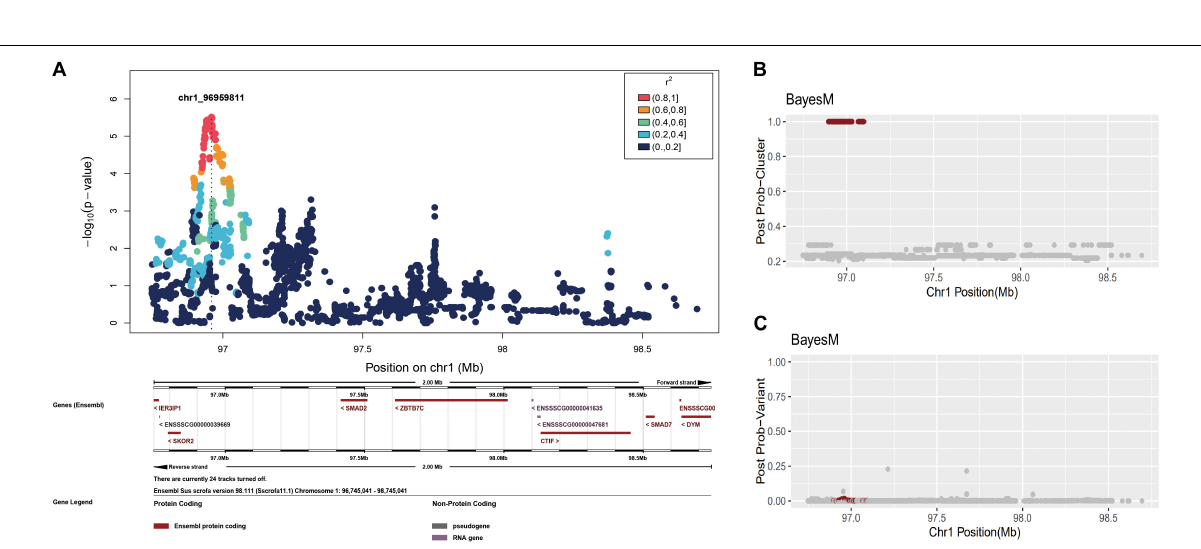
Frontiers in Genetics |